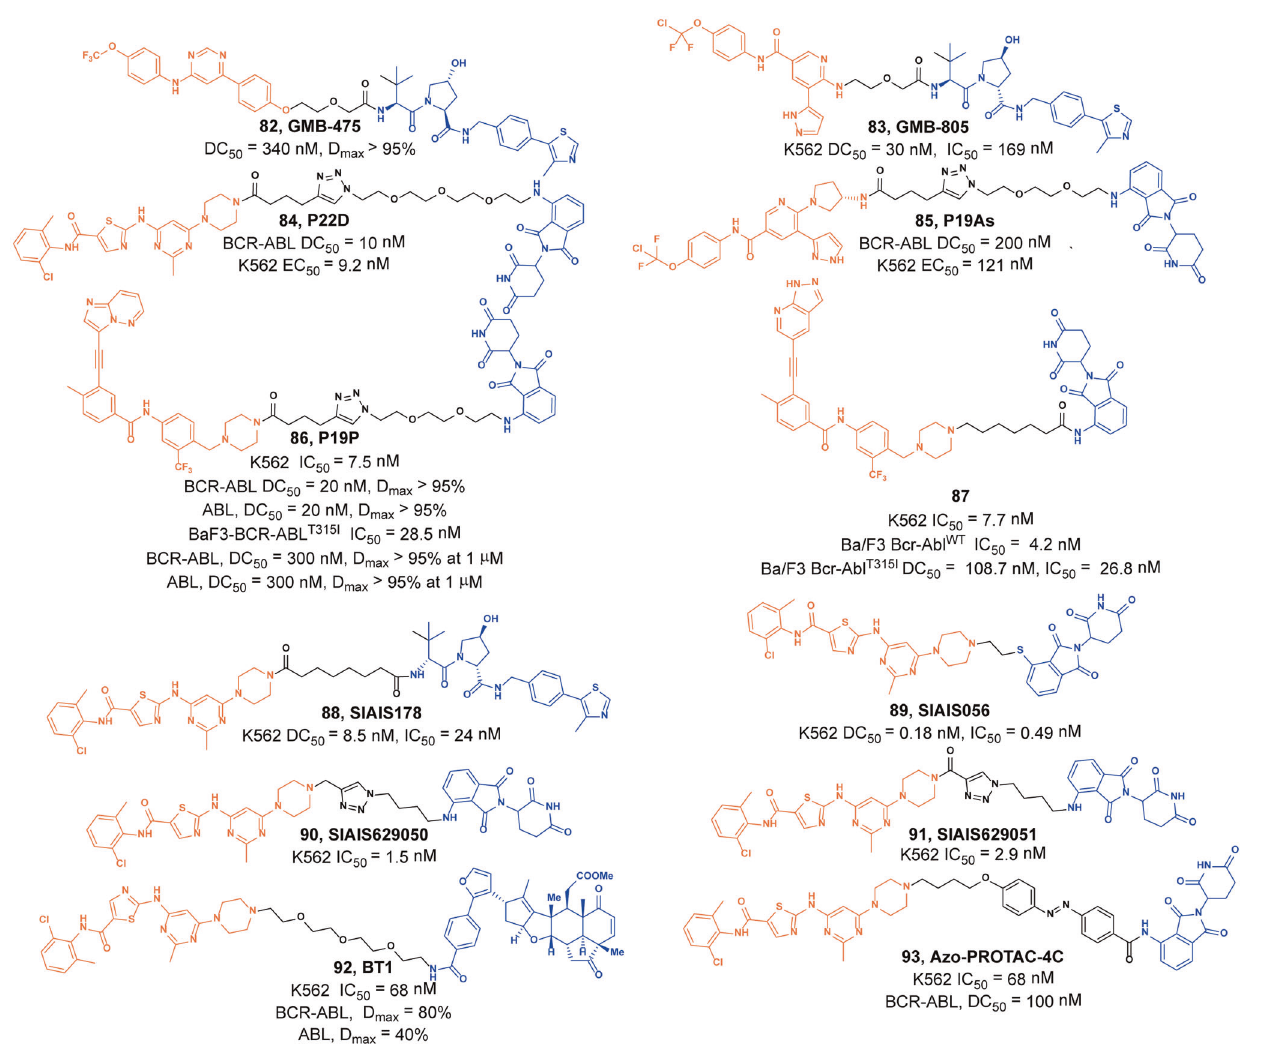
Fig. 21 The representative PROTACs targeting